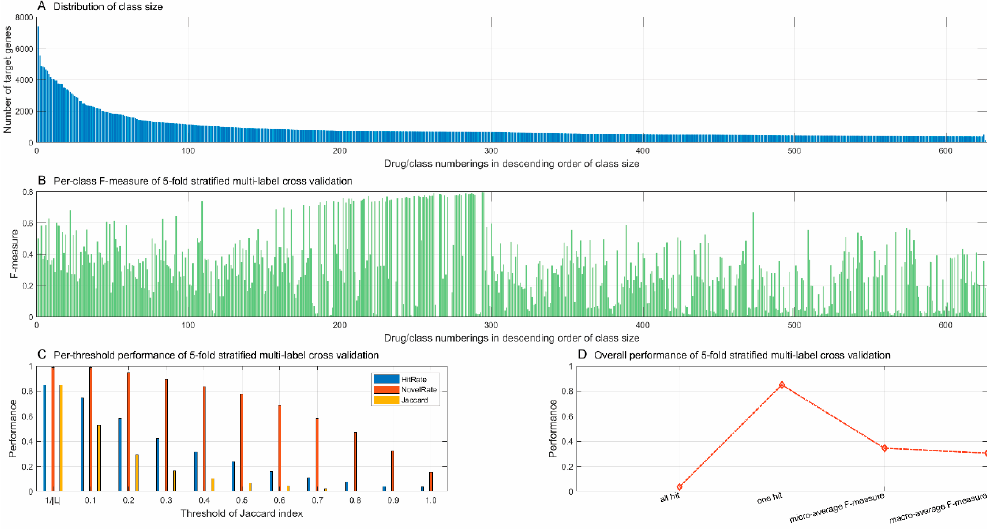
Figure 2. Class size distribution of training data ( A ) and performance of 5-fold stratified multi-label cross-validation ( B – D ).